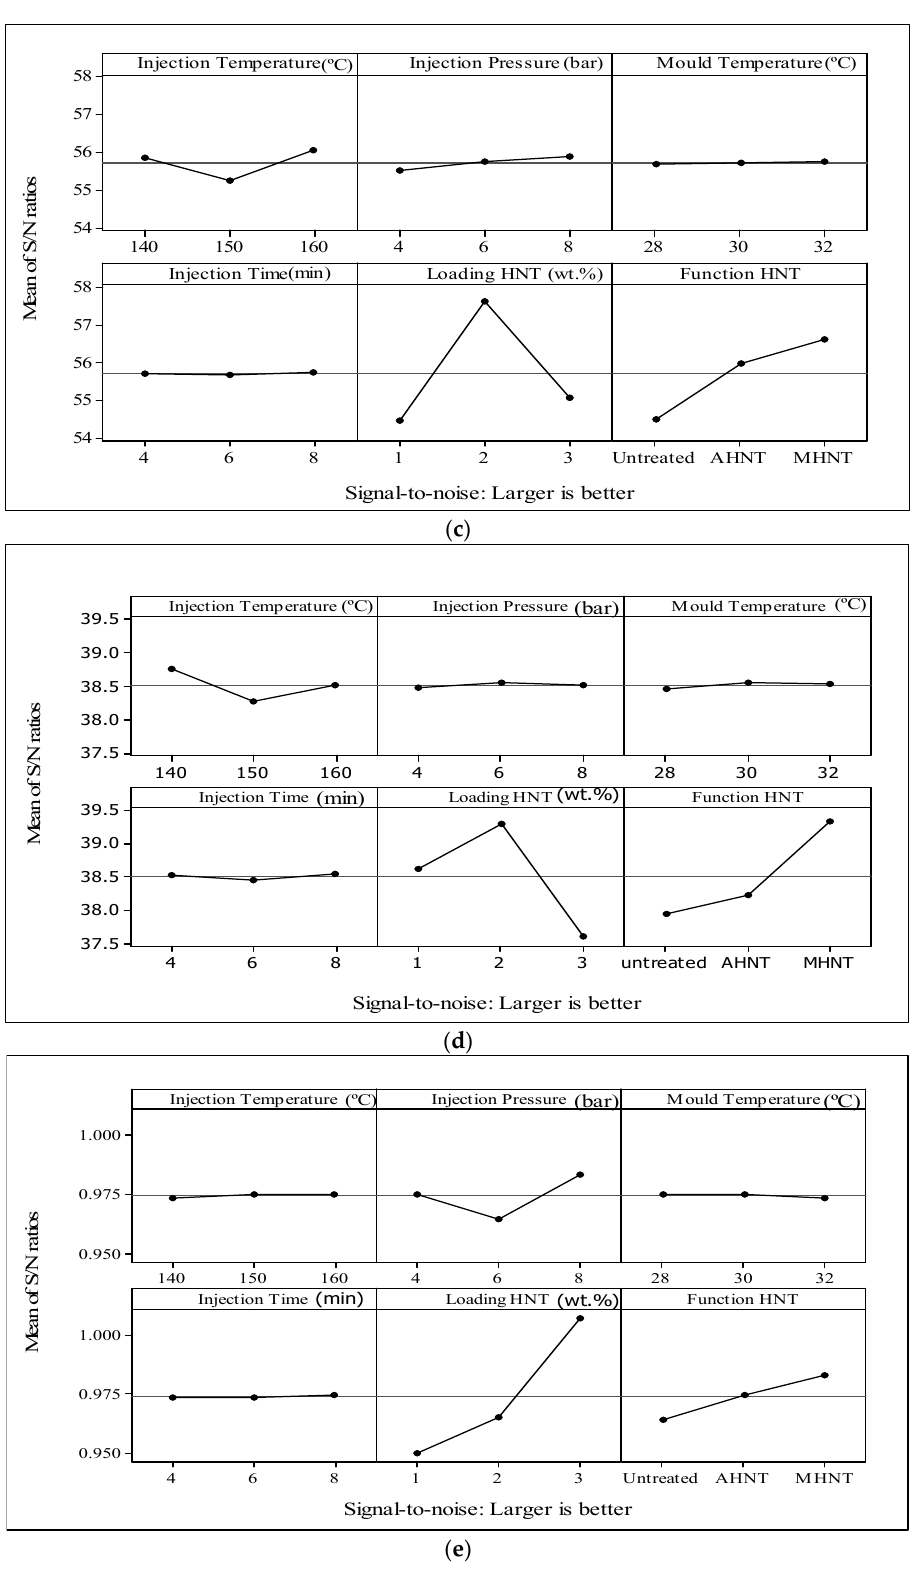
Figure 5. The effect of the levels of the control parameters on the responses: ( a ) tensile strength; ( b ) Young’s modulus; ( c ) tensile strain; ( d ) hardness; and ( e ) density.